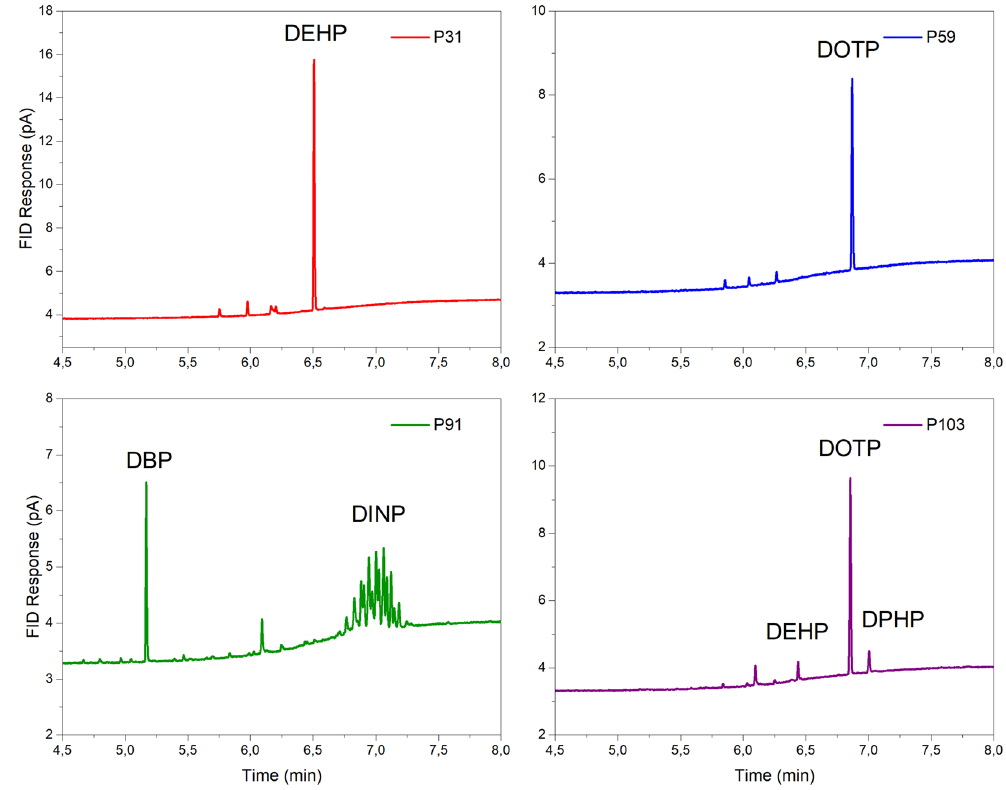
Figure 1. GC-FID chromatograms of hexane solutions of different PVC samples. Sample P31 with DEHP; sample P59 with DOTP, sample P91 with DBP and DINP and sample P103 with DOTP, DPHP and DEHP. Unassigned peaks also occur in blank